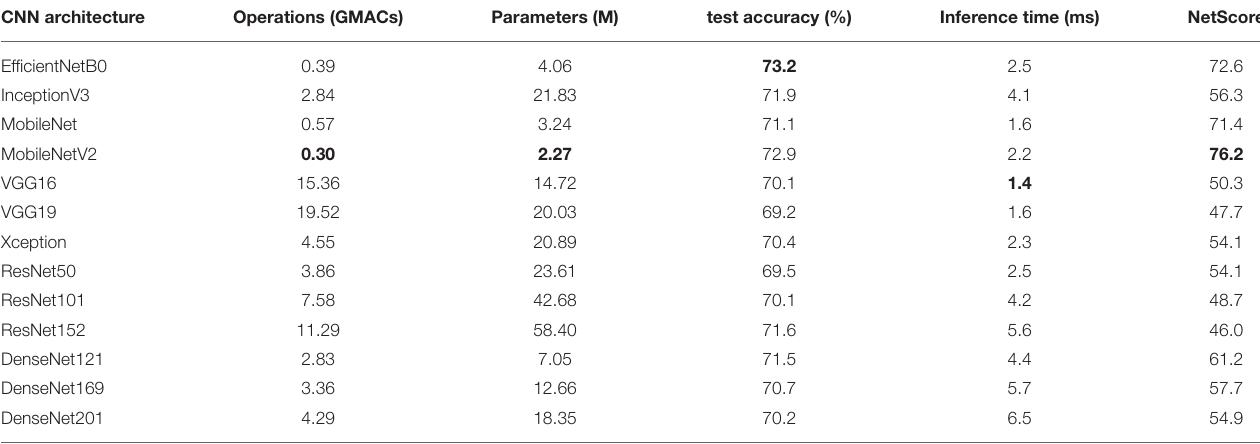
TABLE 5 | The benchmarked CNN architectures and their environment classification performances during inference on the ExoNet database. CNN